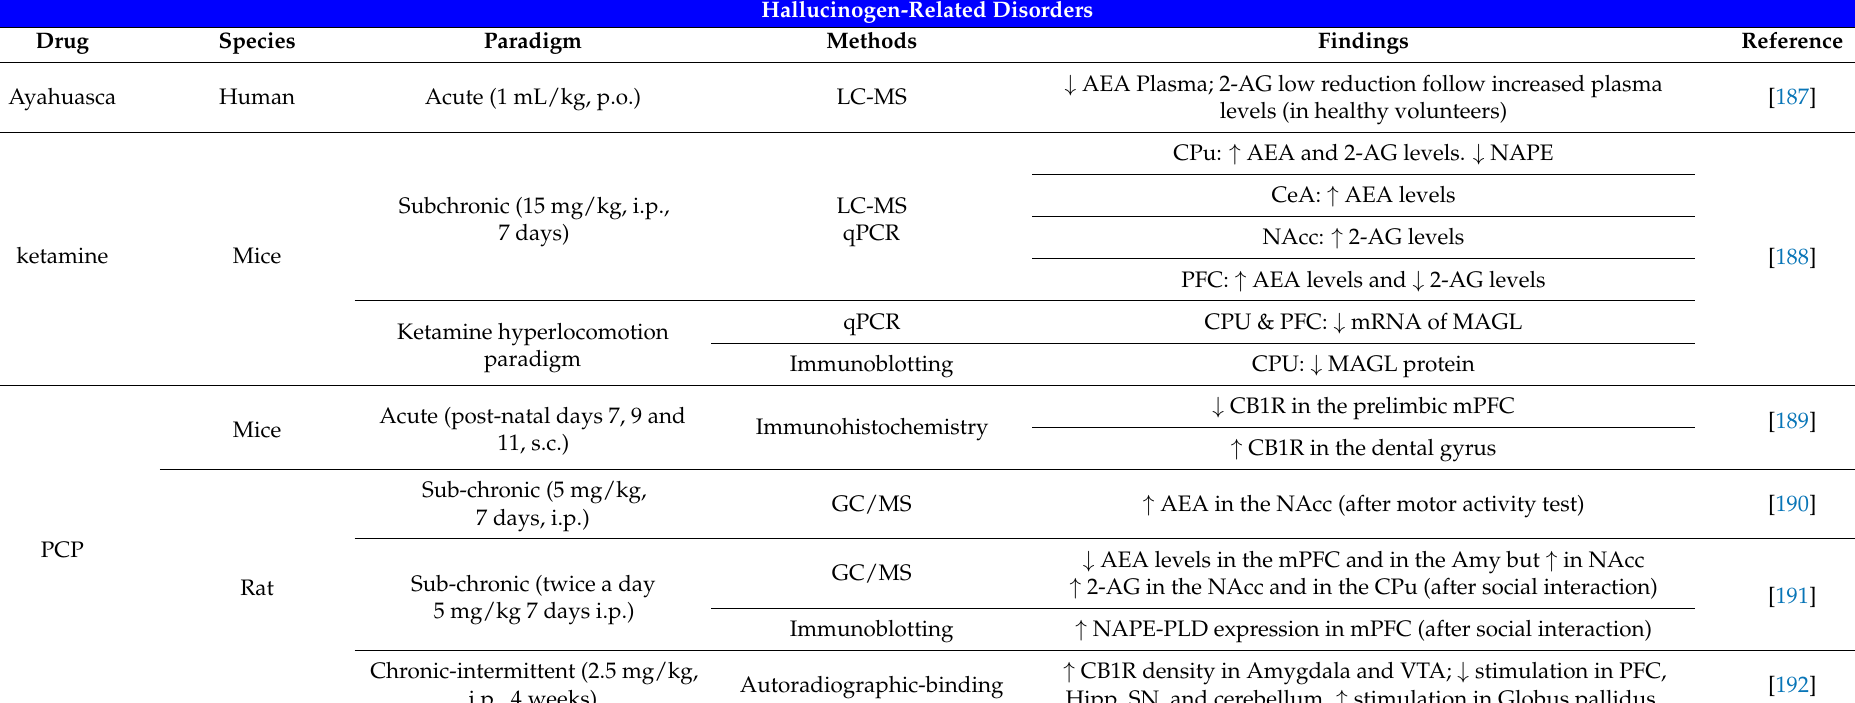
Table 6. Main findings from human and animal studies aiming to identify alterations of ECS components in hallucinogen-related